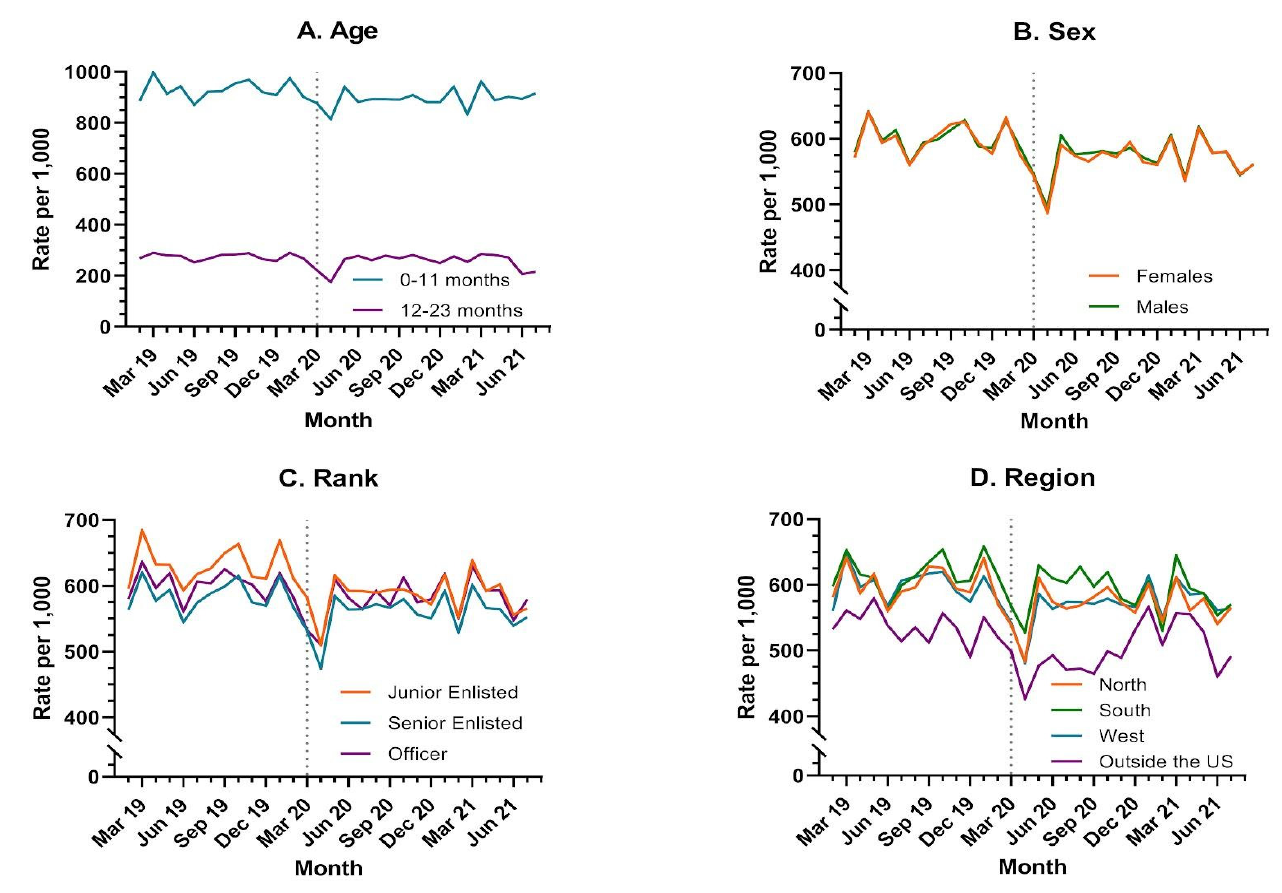
Figure 3. Vaccination Rates by Demographic Category: Rates of the administration of vaccines in children less than 24 months are reported per 1000 enrollees by ( A ) Age by ( B ) Sex by ( C ) Rank and by ( D ) Geographic Region of the Military Health System. Table 5. Vaccination Rate Ratios.